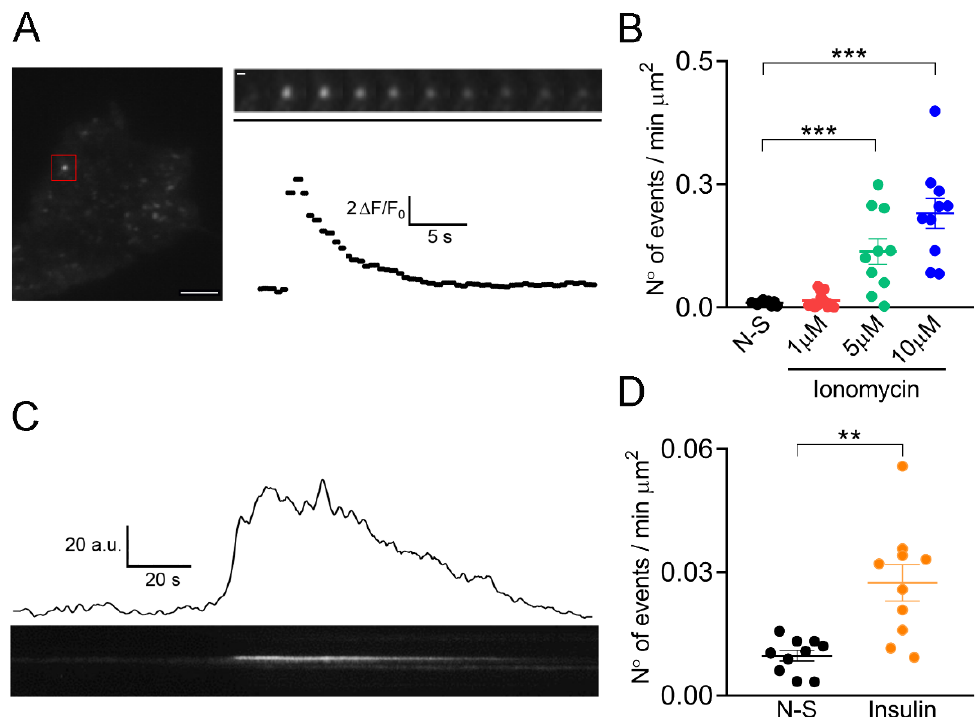
Figure 1. Spontaneous and stimulus-induced fusion events in immortalized human C25 myoblasts. C25 myoblasts were transfected with IRAP-pHluorin, and exocytosis was monitored 48 h later by TIRFM. ( A ): The left panel shows a TIRFM image showing spontaneous fusion events in a non- stimulated C25 cell. Scale bar = 10 µ m. The red square indicates a selected fusion event. The sequence of video frames of this event is shown in the upper right panel (every other frame was skipped). Scale bar = 0.5 µ m. Time scale bar (black line) = 5.58 s. The fluorescence intensity time progress profile of this event is shown below the frame sequence. ( B ): Frequency of events in C25 myoblasts non-stimulated (N-S; 10 cells) or stimulated with 1, 5 or 10 µ M ionomycin (12, 10, and 10 cells, respectively). Dots represent values obtained from individual cells from at least three independent cultures. Horizontal lines indicate means with SEM, respectively. *** p < 0.001 compared to the non-stimulated condition (ANOVA test followed by Bonferroni multiple comparison test). ( C ): A typical example of a fluorescence trace (above) and kymograph (below) showing the evolution in time of a fusion event in C25 myoblasts, stimulated with 10 µ M ionomycin. ( D ): Frequency of events in C25 myoblasts non-stimulated (N-S; 10 cells) or stimulated with 100 nM insulin (10 cells). Dots represent values obtained from individual cells from at least three independent cultures. Horizontal lines indicate means with SEM, respectively. ** p < 0.01 (Student’s t